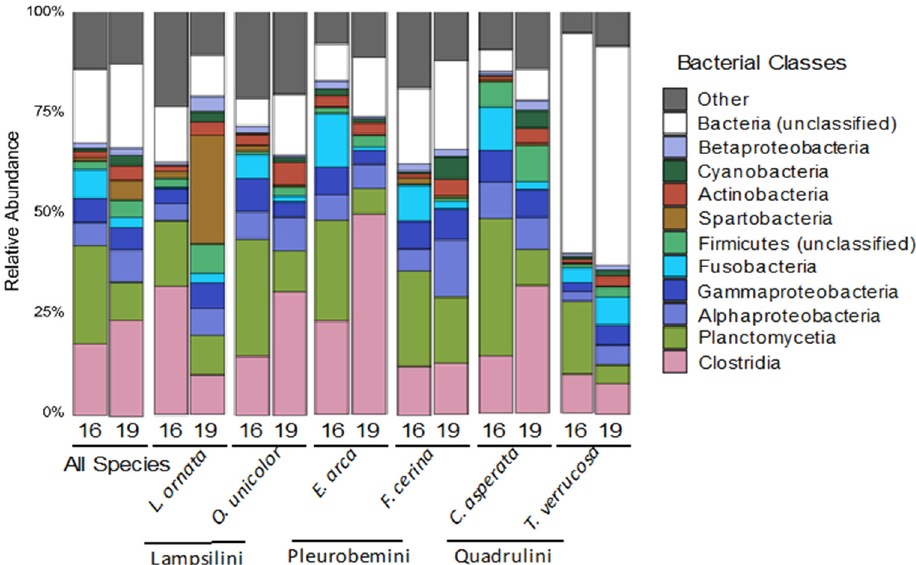
Figure 2. Relative abundance of the ten most abundant bacterial phyla/classes in the gut microbiome of six species of Unionidae mussels sampled between 2016 and 2019 at the same site on the Sipsey River, AL, USA, as determined from 16S rRNA gene sequence counts. Mussel species were Lampsilis ornata , Obovaria unicolor , Elliptio arca , Fusconaia cerina , Cyclonaias asperata , and Tritogonia verrucosa . Tribes are listed below member species. Each bar represents the average microbiome for species collected in 2016 (16) and 2019 (19). Class “Other” includes 74 bacterial classes, each less than 2% of sequences in the entire dataset.